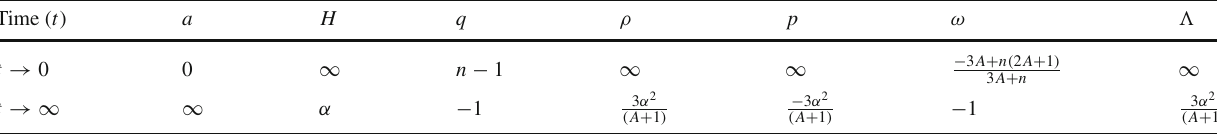
Table 1 Behavior of cosmological